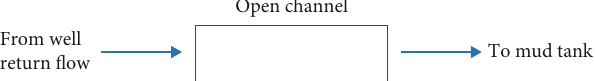
Figure 1: The open channel is located between the choke valve and the mud